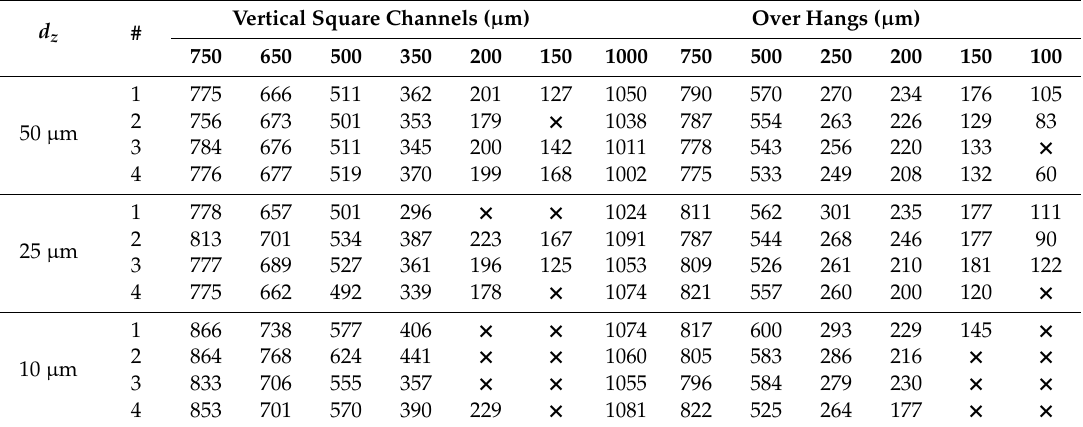
Table 5. Average measured width of the vertical square channels and the thickness of the